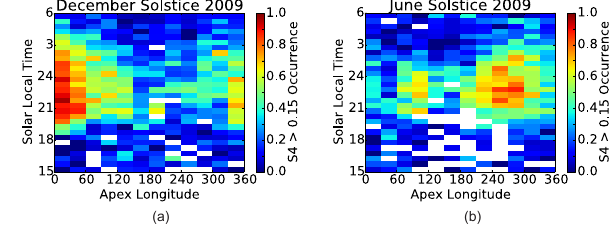
Fig. 5. COSMIC scintillation occurrence determined from RO data.